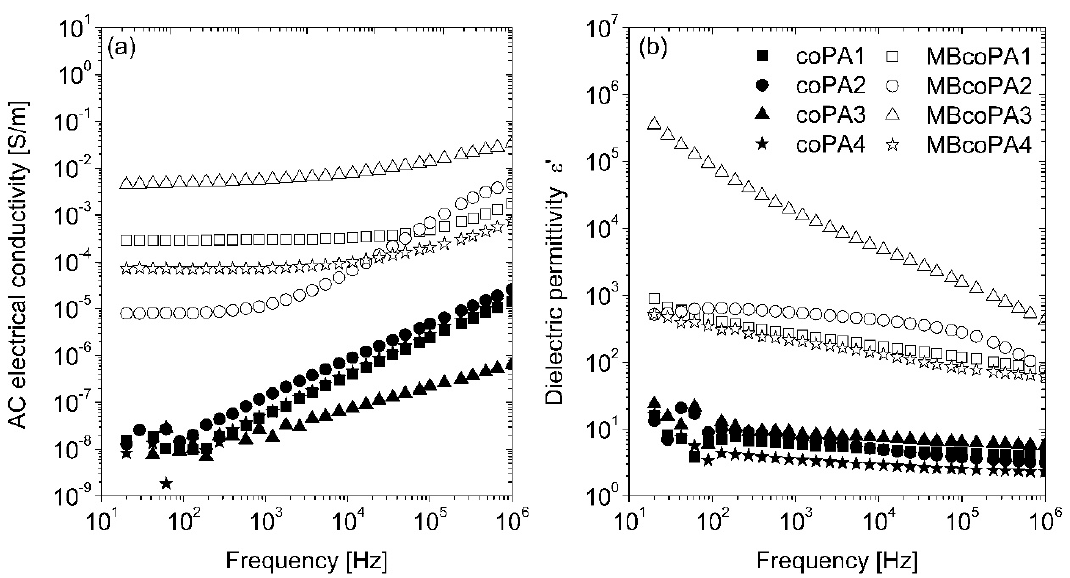
Figure 4. Comparison of: ( a ) the real part of the electrical conductivity; and ( b ) the real part of the dielectric permittivity for the neat coPAs and their masterbatches containing 7 wt % MWCNT.